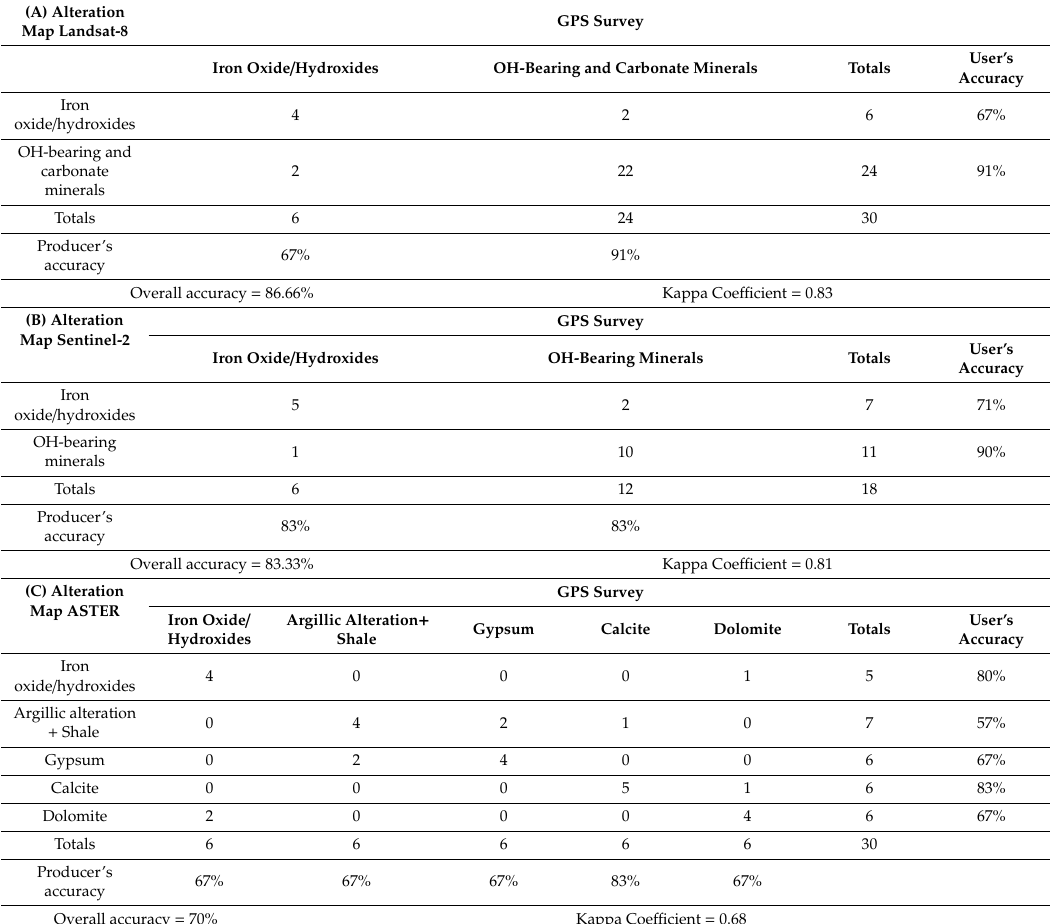
Figure 15. ASD spectroscopy results (0.35 to 2.5 µm spectral range) for rock samples collected from shale, gypsum, dolomite and calcite lithological units in the study area. Table 7. Confusion matrix for alteration mapping derived from remote sensing datasets versus field GPS survey. (A) Landsat-8 data; (B) Sentinel-2 data; (C) ASTER data; (D) WV-3